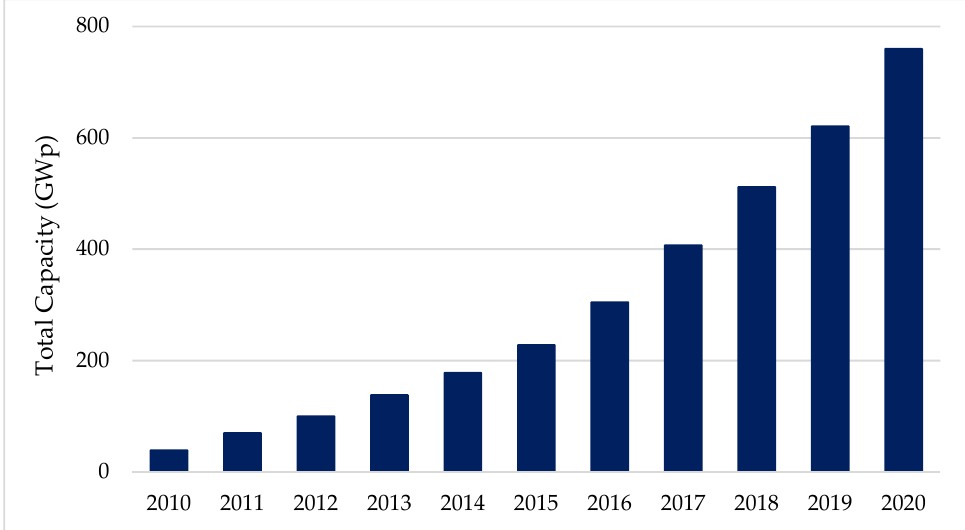
Figure 1. Total global installed capacity of solar PV in 2010–2020. Reproduced from [2,3], REN21 Secretariat: 2020/2021. Reprinted with permission from Refs. [2,3]. Copyright 2020/2021 REN21 Secretariat.